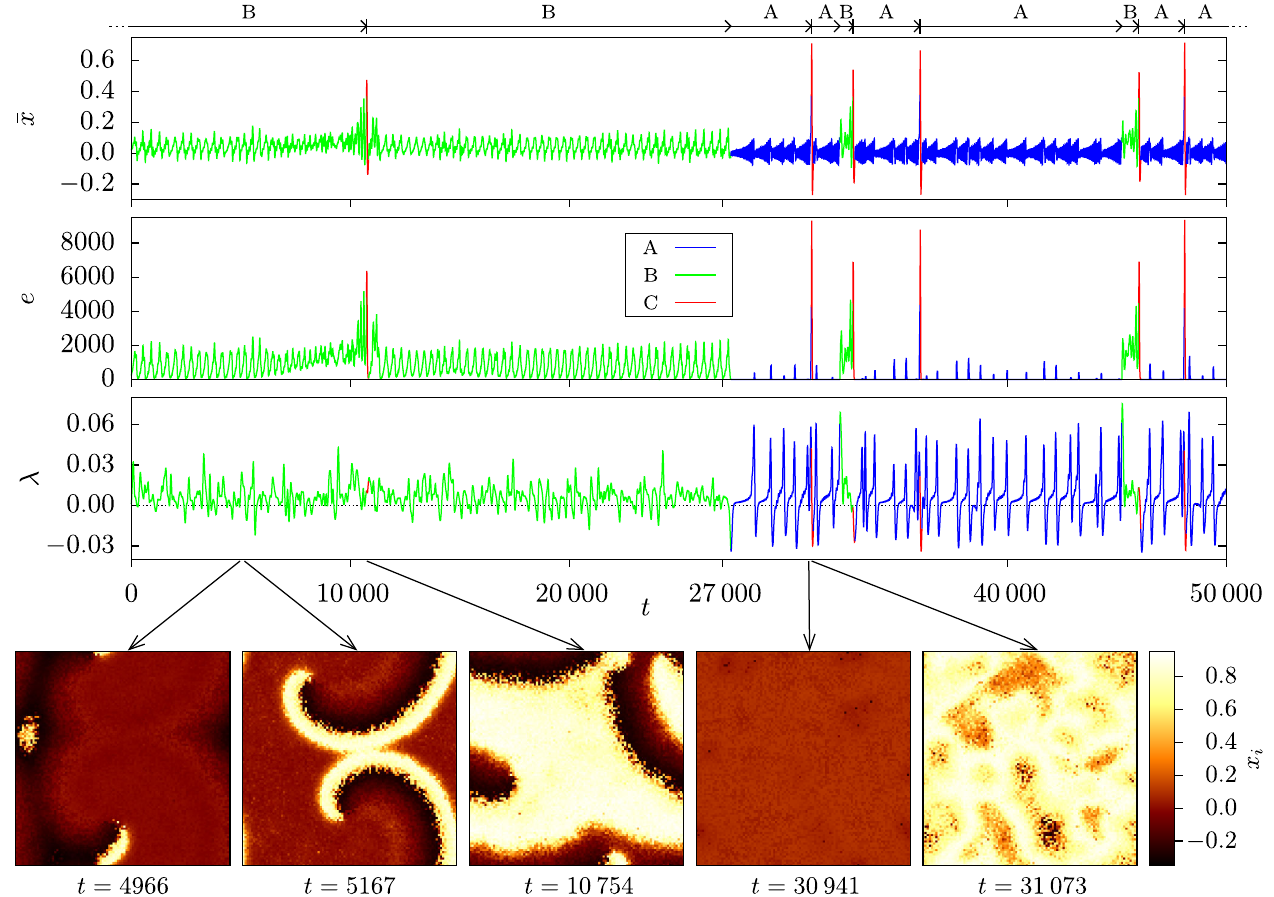
FIG. 1. First to third row: Exemplary temporal evolutions of ¯ x , of the number e of units with x i > 0 . 4 ( “ excited units ” ), and of an estimate λ of the largest local Lyapunov exponent (temporal evolution smoothed with a Gaussian kernel with a width of 30 to improve readability). The line colors indicate the patterns as automatically classified (blue: A, low-amplitude oscillations; green: B, waves; red: C, extreme events). These patterns are also indicated at the very top with pattern C being indicated with a vertical line. Bottom: Snapshots of the spatial distribution of x i ð t Þ at times corresponding to selected local minima and maxima of ¯ x (from left to right): adjacent minimum and maximum around t ¼ 5000 , the maximum during the event around t ¼ 10 000 , the minimum before the event around t ¼ 30 000 , and the maximum during that event. Units are represented by pixels, which are arranged according to the lattice underlying the small-world network and whose color encodes the value of the respective x i